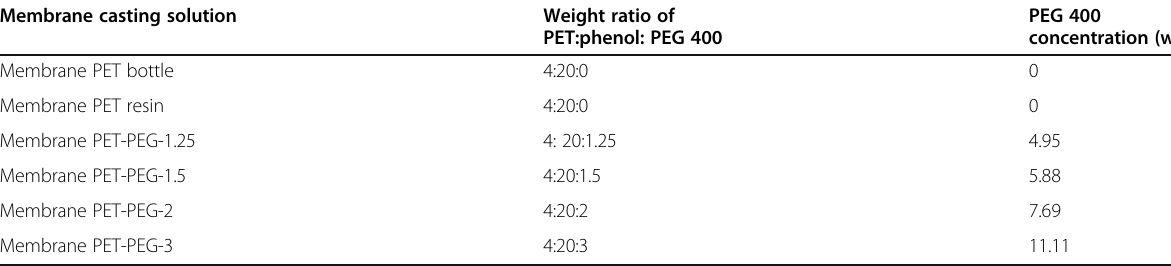
PEG 400 concentration (wt%)